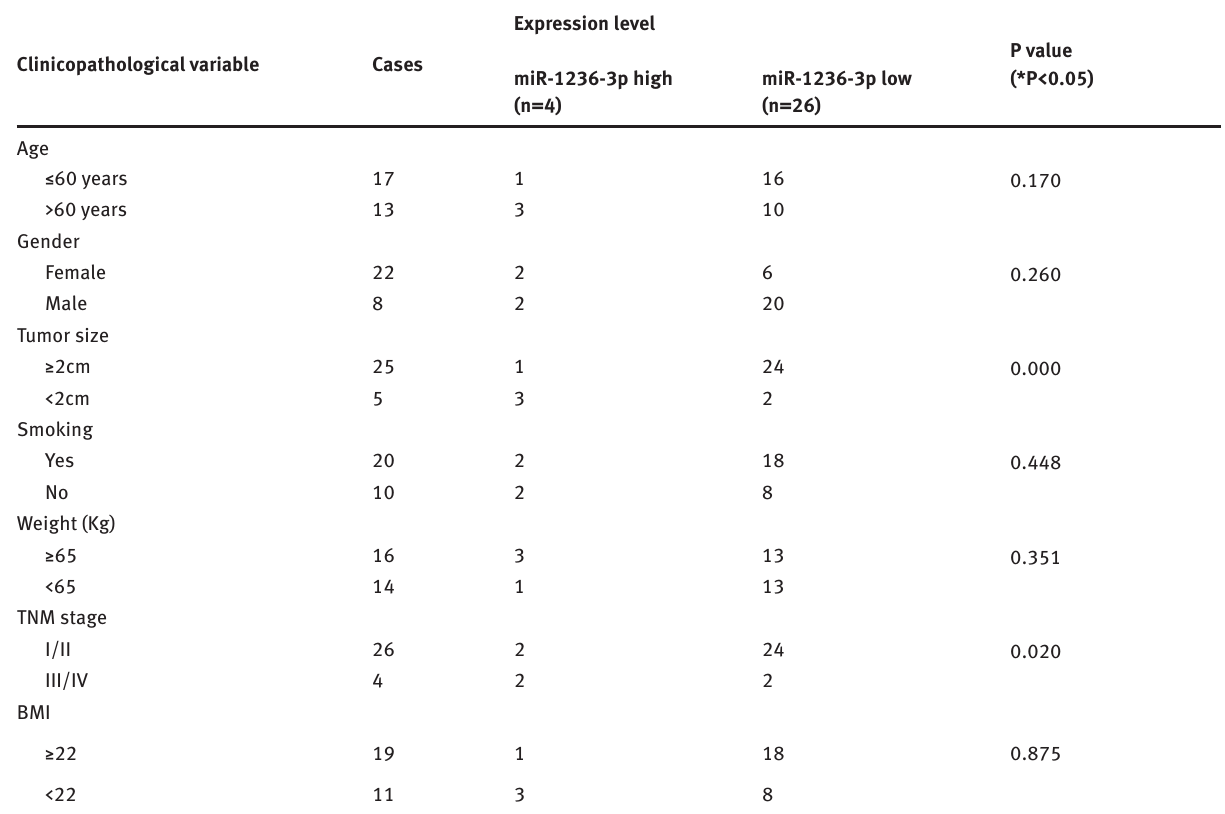
Table 1: Clinicopathological features in 30 lung cancer tumor specimens